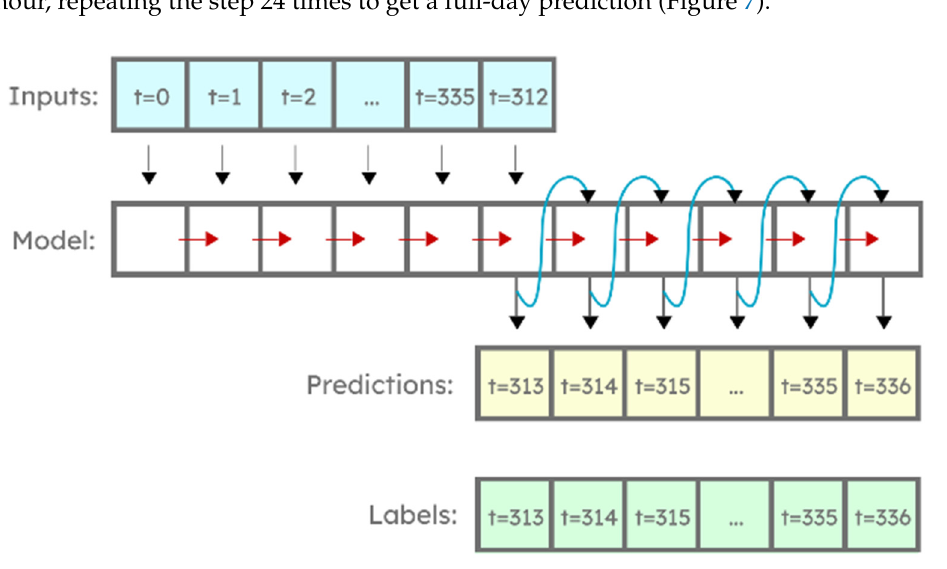
Figure 7. Autoregressive LSTM used in this test.